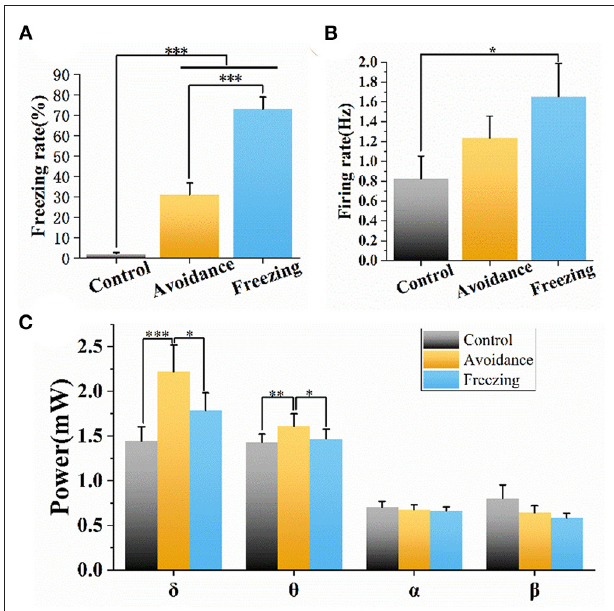
FIGURE 6 | Freezing rate, firing rate, and LFP power of mice in the three stages. (A) Freezing rate of mice in the three stages. (B) Firing rate of mice in the three stages. (C) LFP power of different frequency bands in three stages. Data are means ± SE. One-way repeated measures ANOVA. * p < 0.05; ** p < 0.01; *** p < 0.001. n = 6